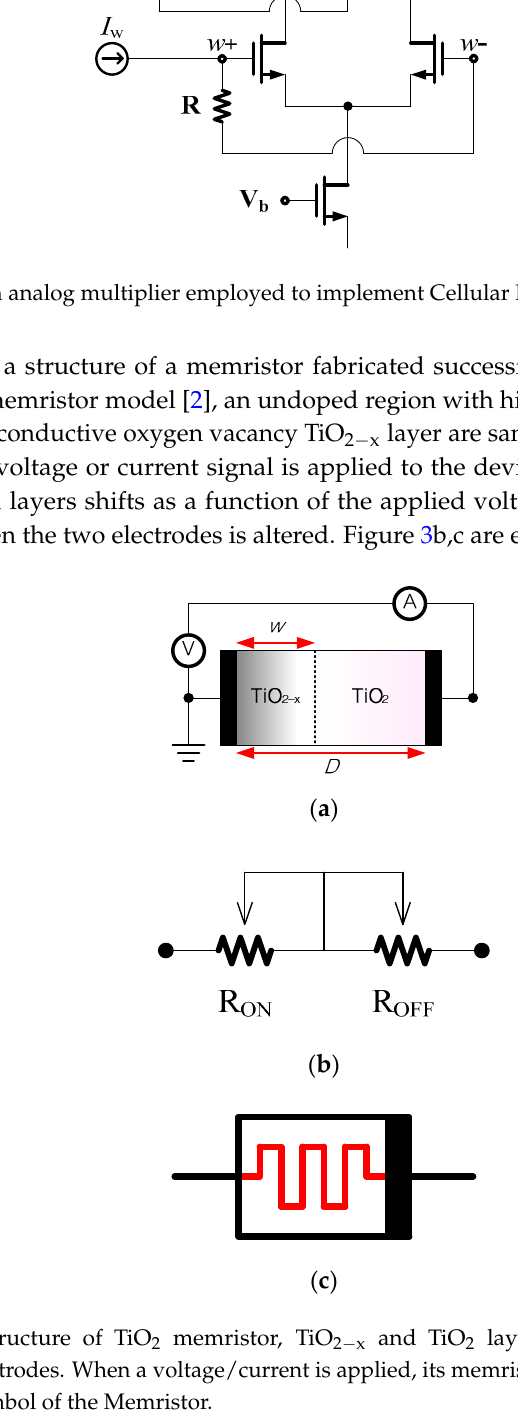
Figure 1. Inputs and outputs of a biological neuron where inputs (dendrites) are denoted as “b” in the figure and outputs (axons) are denoted as “a”. Since one synapse is connected at each input (dendrite), a huge number of synaptic weights are composed at a neuron.